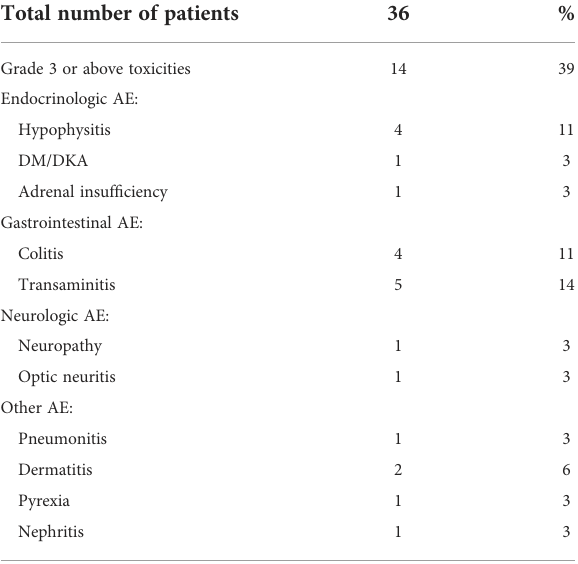
TABLE 6 Toxicities per common terminology criteria for adverse events version 5.0 of patients with mucosal melanoma treated with neoadjuvant checkpoint